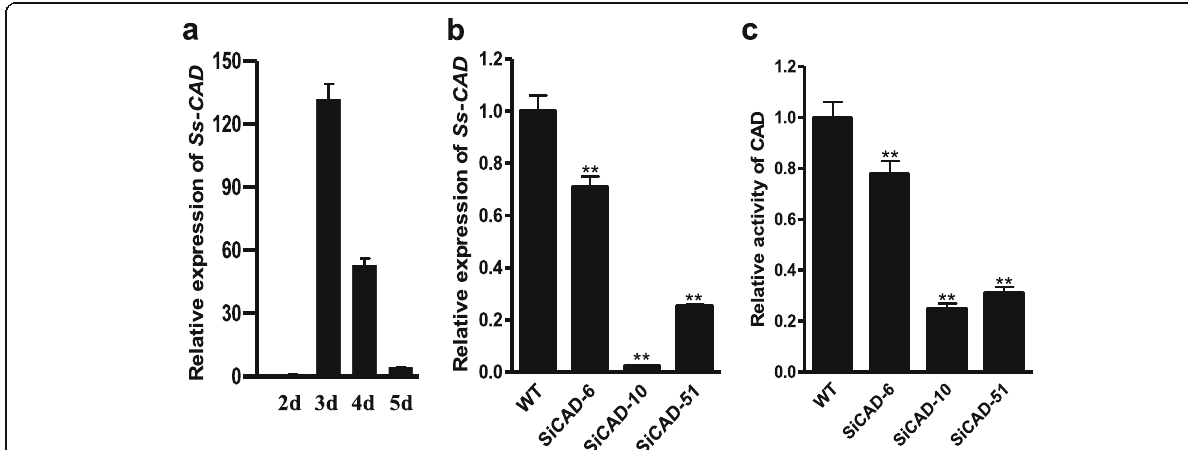
Fig. 1 Ss-CAD -silenced transformants showing reduced Ss-CAD expression levels and CAD activity. a Ss-CAD cDNA expression levels were measured by qRT-PCR and were normalized to that of actin cDNA in extracts taken from each developmental stage. cDNA abundances from samples grown on PDA for 2 d were assigned a value of 1.0. For all experiments, three independent replicates were performed. b qRT-PCR analysis of Ss-CAD transcript accumulation in Ss-CAD -silenced transformants. Ss-CAD expression in the wild-type strain Ep-1PNA367 served as control. Hyphal masses from 3-day-old colonies on PDA were collected for gene expression analysis. c CAD activity in the wild-type strain and Ss- CAD -silenced transformants was measured by enzyme activity assays. CAD activity in the wild-type strain was assigned a value of 1.0. Three